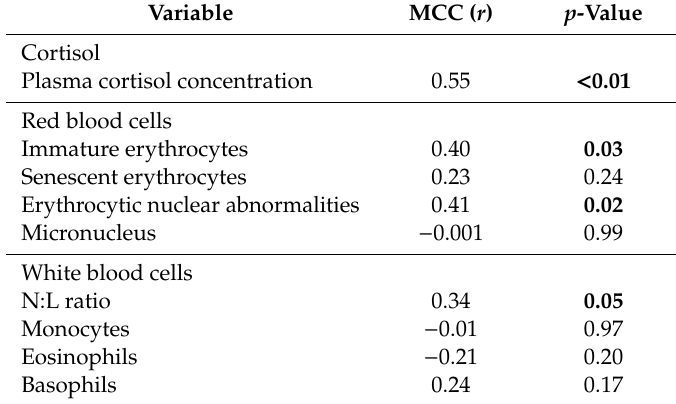
Table 3. Correlation ( r ) and p -value between hematological variables and skin mucus cortisol concentrations